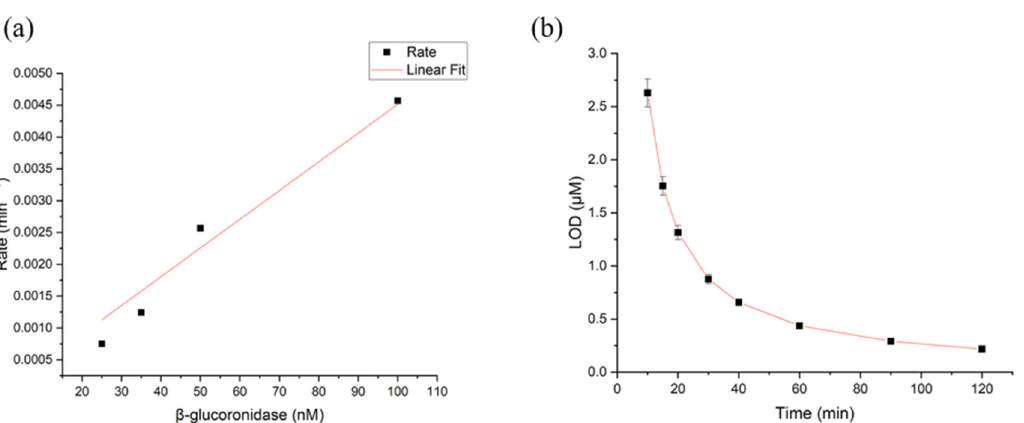
Figure 11. ( a ) Initial apparent rates of reaction plotted against the initial concentrations of the en- zyme for PUAA MS hydrogel films (error bars: standard error mean, n = 3) ( b ) LOD for β -GUS enzyme for different observation times using 40 µm hydrogel films.